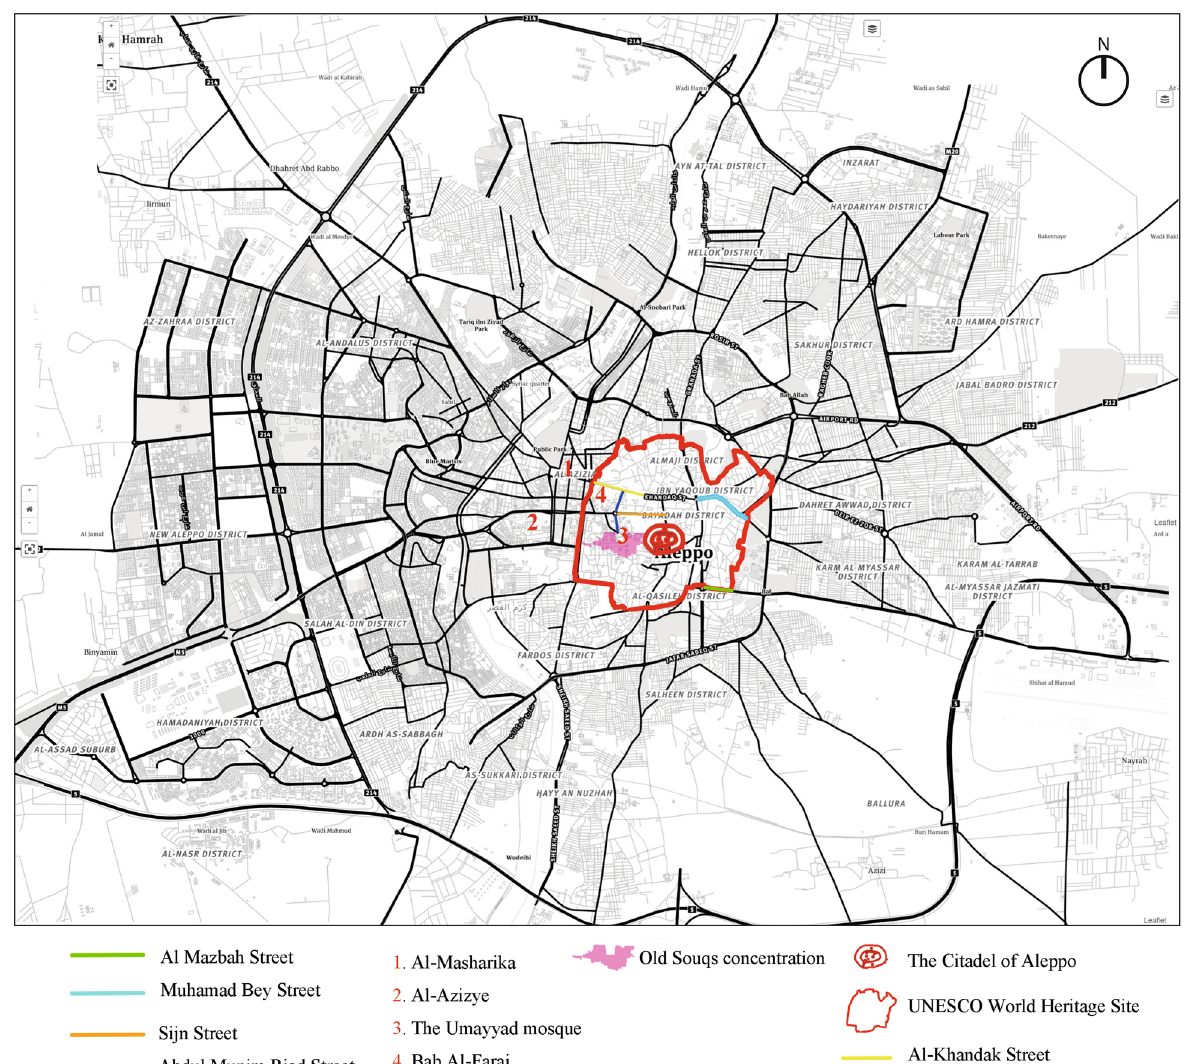
Fig. 1 A map of Aleppo (Source: the Author, background from